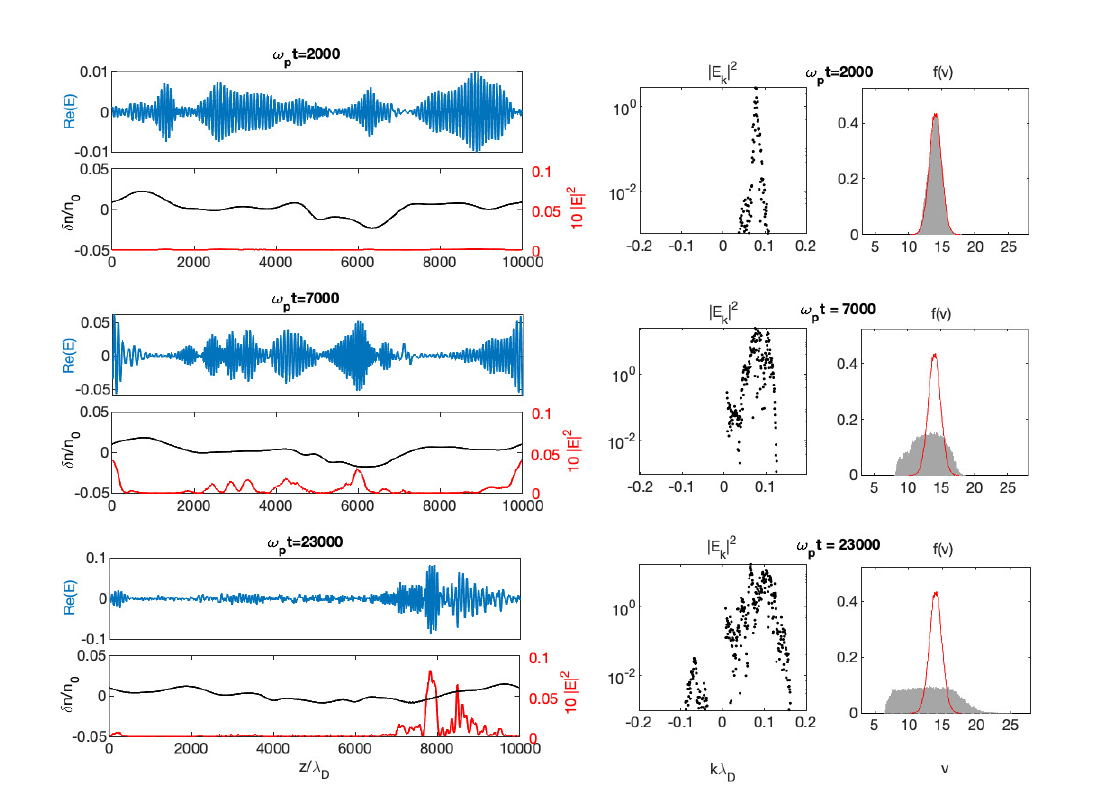
Figure 3. Beam dynamics’ and wave packet’s evolution at three moments of time, ω p t = 2000, 7000 and 23,000 (from upper to lower rows). ( Left panels): Spatial profiles of the electric field envelope Re E (blue) and of the energy density | E | 2 × 10 (red), superposed to the density fluctuations δ n / n 0 (black). ( Middle panels): Corresponding electric field spectra | E k | 2 in logarithmic scales. ( Right panels): Corresponding electron velocity distributions f ( v ) (grey surfaces), superposed to the initial distribution (red curves). Main parameters are the following : v b / v T = 14, ∆ v b / v b = 0.08, n b / n 0 (cid:39) 2.5 × 10 − 5 , ∆ n (cid:39) 0.01. All variables are